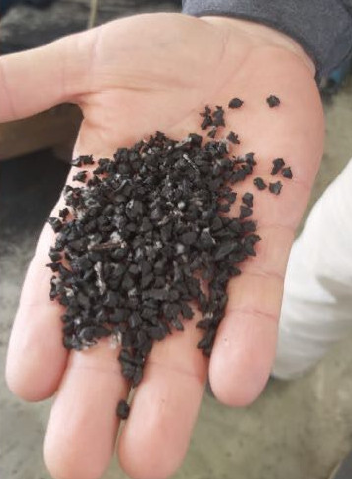
Figure 1. Ground rubber aggregate.